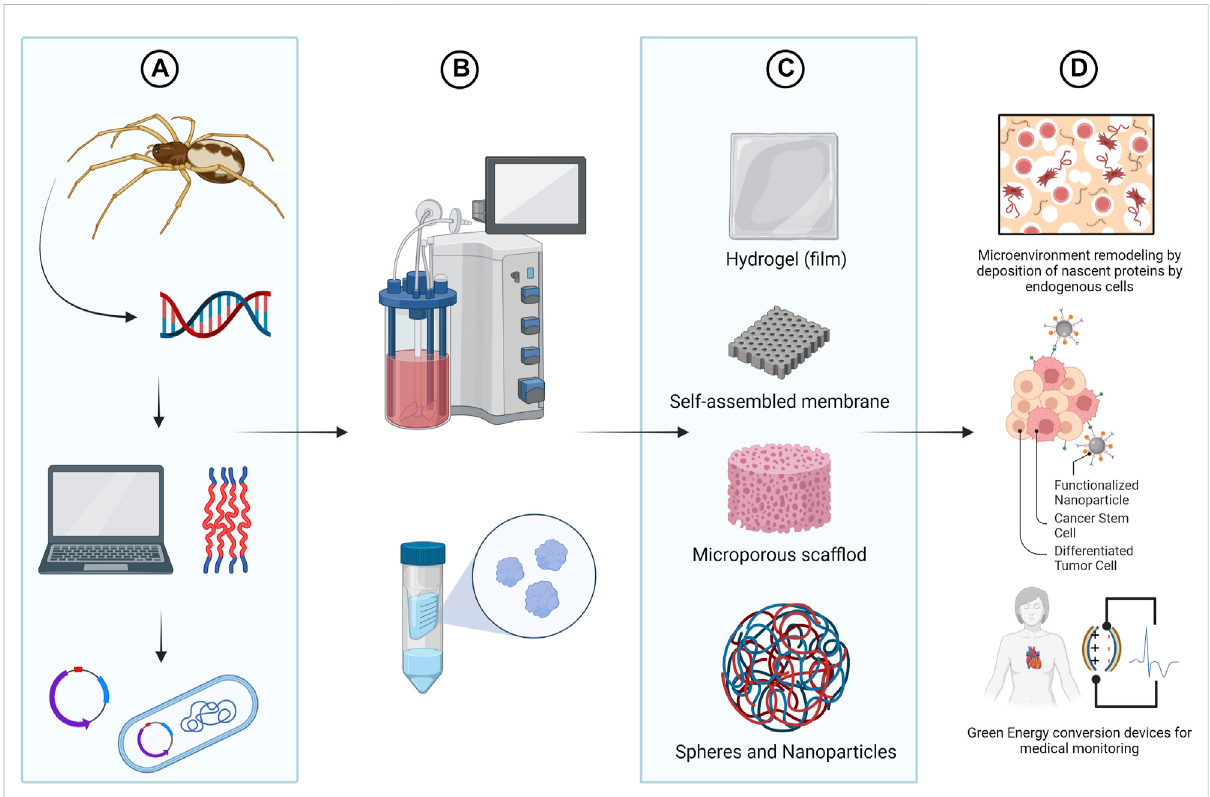
FIGURE 4 Bioengineeringofspidersilks.Usingsyntheticbiologytoolsitispossibletodesignspidersilkswithtailormadefunctionalities (A) andtoproduce recombinant spider silk protein (rSSP) using heterologous expression systems (B) . Although in nature only fi bers are formed from spidroins, in vitro , rSSP can be molded in different morphologies including nano fi brils, particles, capsules, hydrogels, fi lms or foams (C) . The versatility of spidroins, along with their biocompatible and biodegradable nature, also place them as the perfect biomaterial for the design of improved drug delivery systems, tissue engineering scaffolds and biosensor devises (D) . Created with